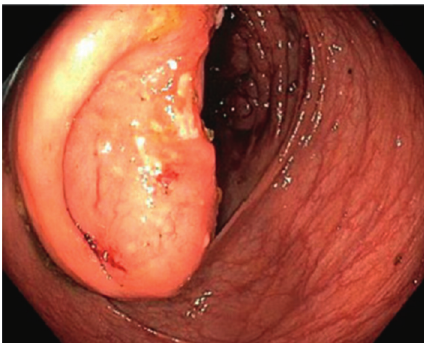
Figure 3: Extraluminal compression and protruding ileocecal valve resulting in narrowing of cecal lumen.